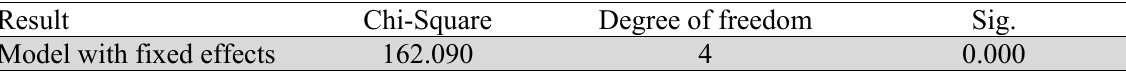
The results of Hausman test Result